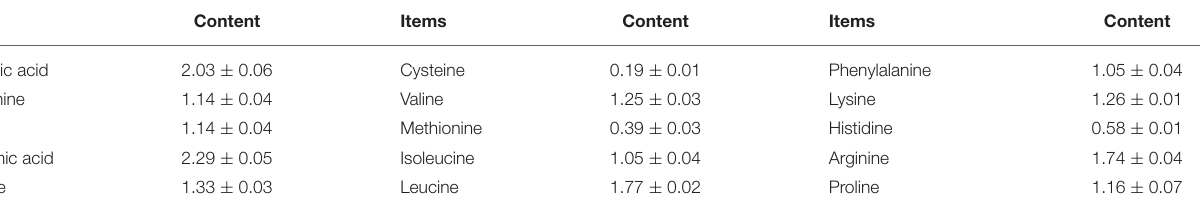
TABLE 3 | Protein content and amino acids composition of Rhodotorula mucilaginosa TZR 2014 (DM basis, %). Items Content Items Content Items Content